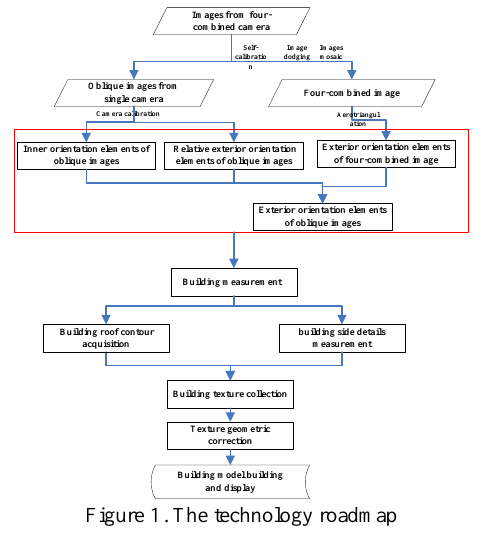
Figure 1. The technology roadmap